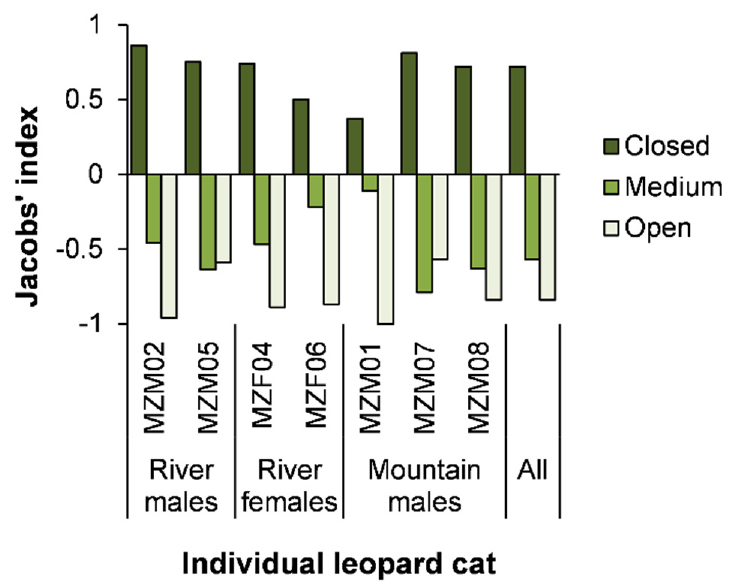
Figure 2. Jacobs’ index for vegetation structure at leopard cat daytime resting sites. Vegetation structures are closed, medium or open and selected (>0.2), avoided (< − 0.2), or used according to availability ( − 0.2–0.2).